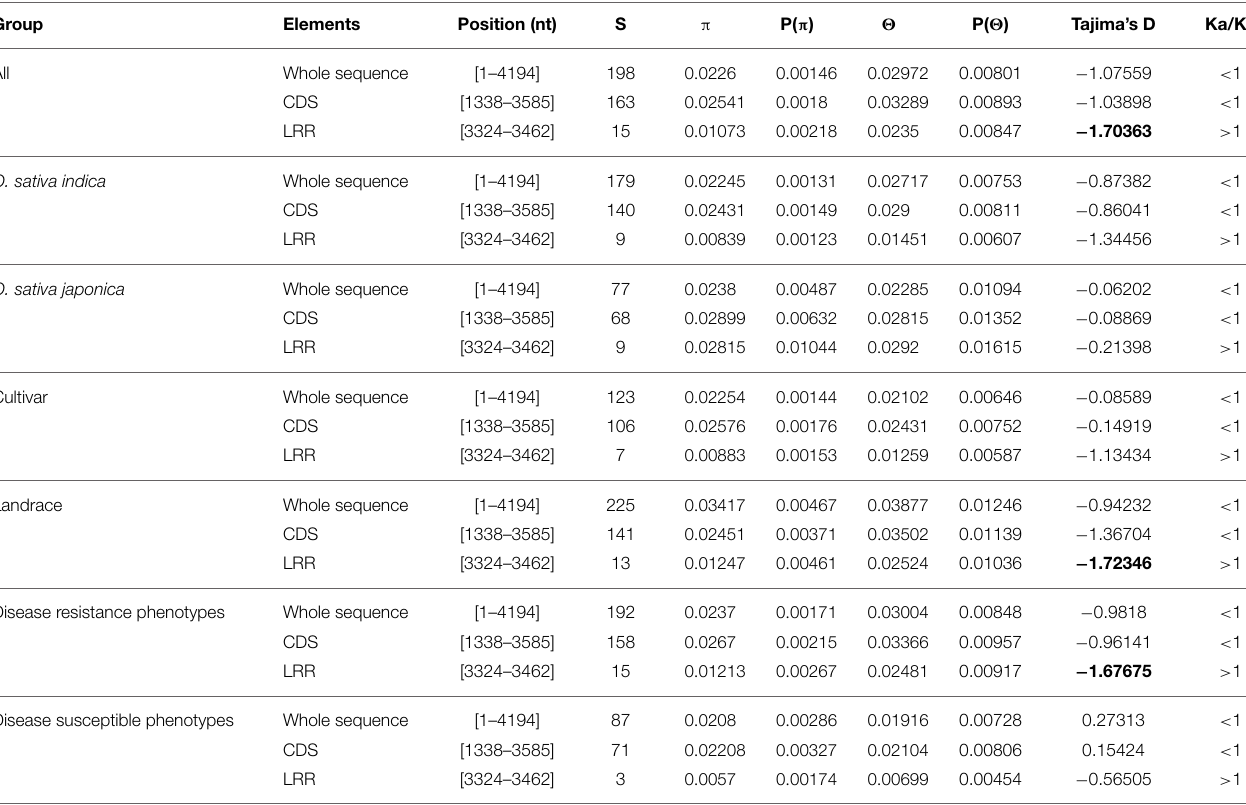
TABLE 2 | Nucleotide polymorphism of the Pi54 alleles mined from different accessions of rice.